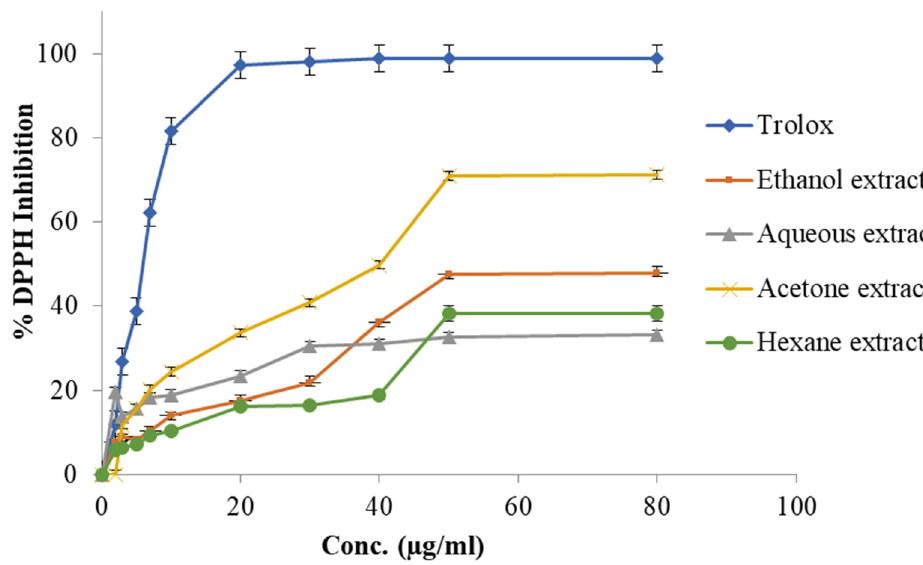
Figure 1. DPPH free radical scavenging activity by Artemisia scoparia four extracts and Trolox. Values are the mean ± SD of triplicate experiments ( p -value < 0.05).